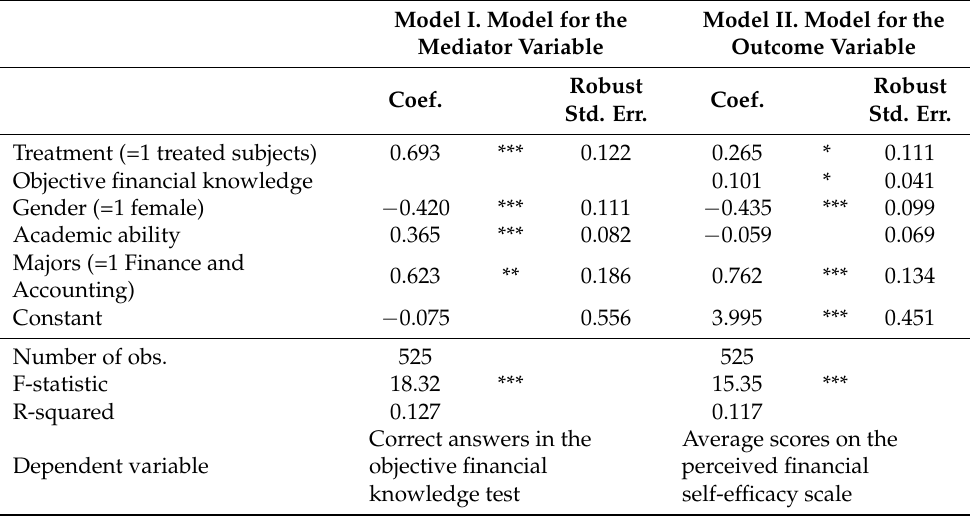
Table 5. Causal mediation analysis in the context of financial education